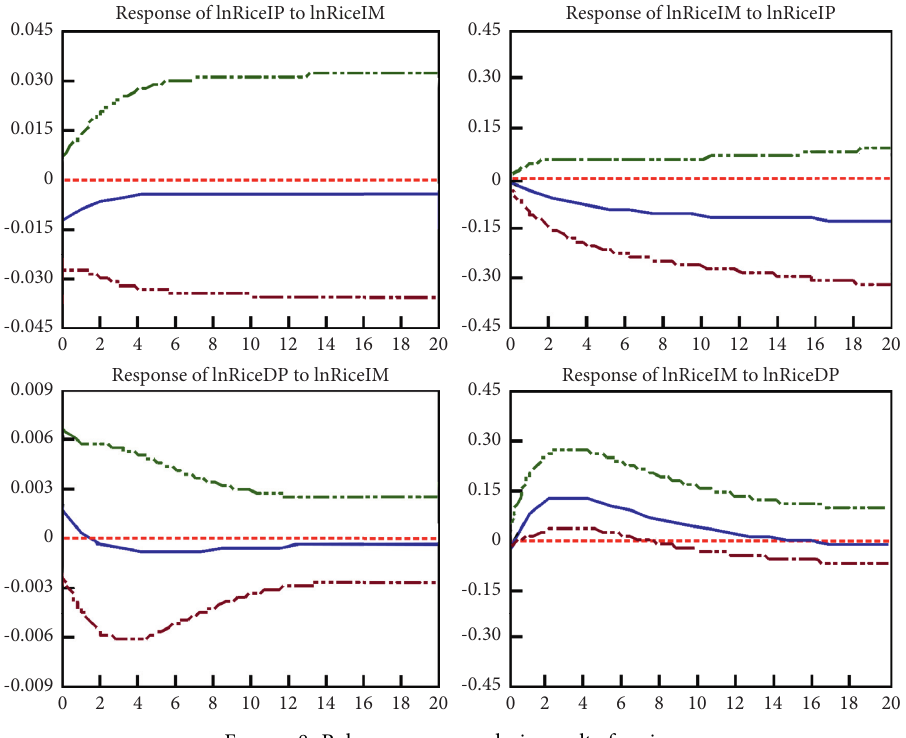
Figure 8: Pulse response analysis results for